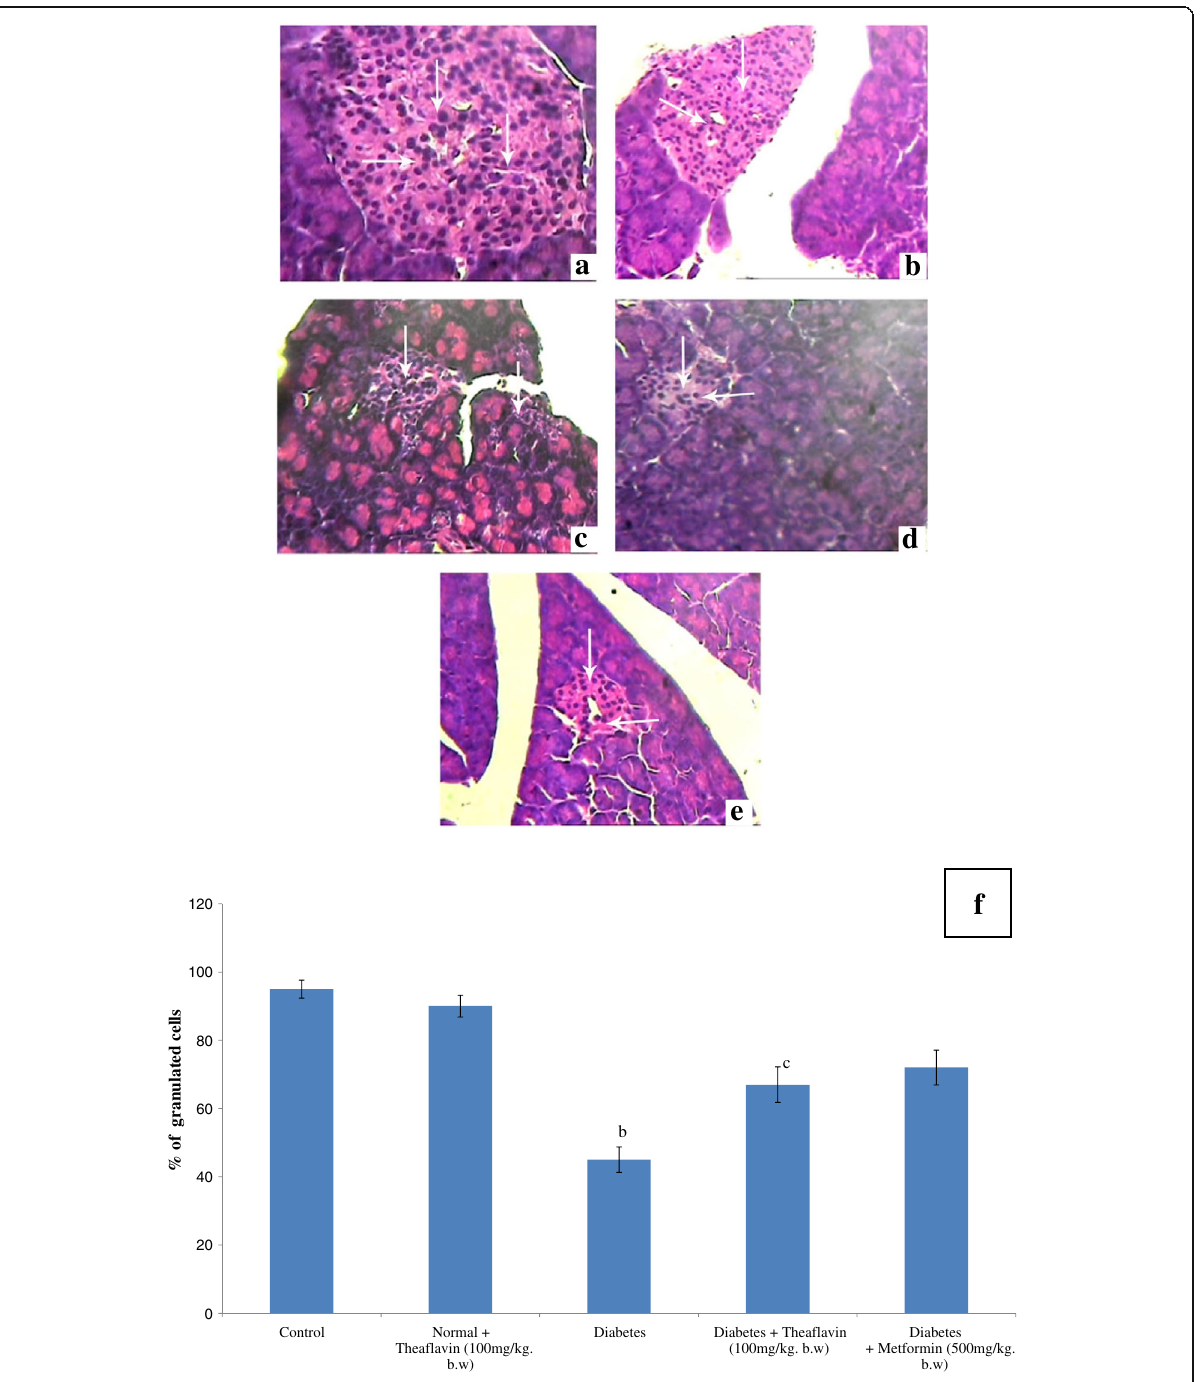
Fig. 2 Histopathological section of pancreas of control and experimental rats (× 40). Control ( a ), normal + theaflavin ( b ), diabetes induced ( c ), diabetic + theaflavin ( d ), and diabetic + metformin ( e ). f Quantification of granulated cells from pancreas. Values are given as mean ± SD for six animals in each group ( n = 6).Values are considered significantly different at P < 0.05 with post hoc LSD test. Comparisons are made as (a) control vs. drug control (theaflavin-alone-treated rat); (b) control rat vs. diabetic rat; (c) diabetic rat vs. theaflavin-treated diabetic rat; (d) theaflavin-treated diabetic rat vs.